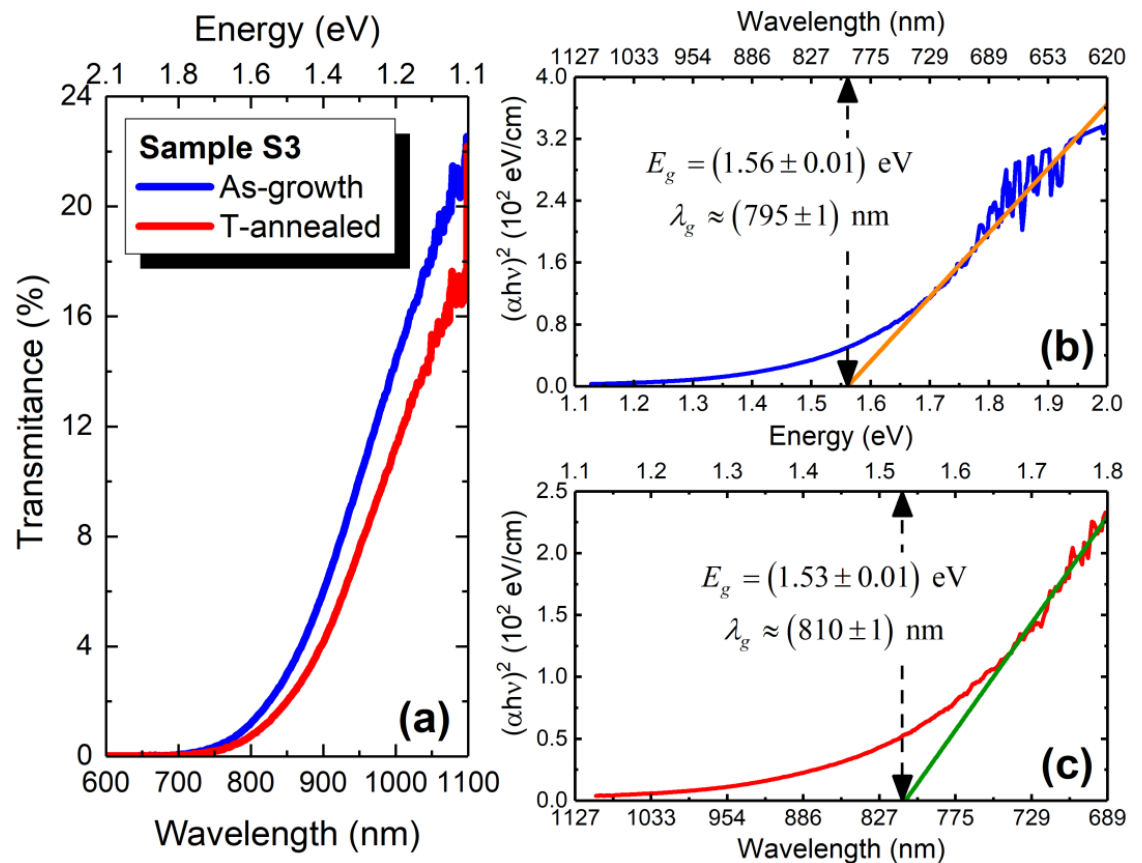
Figure 3. ( a ) Transmittance spectrum of sample S3 before and after the thermal annealing. ( b ) Fitted Tauc plot of sample S3 before and ( c ) after the thermal annealing.